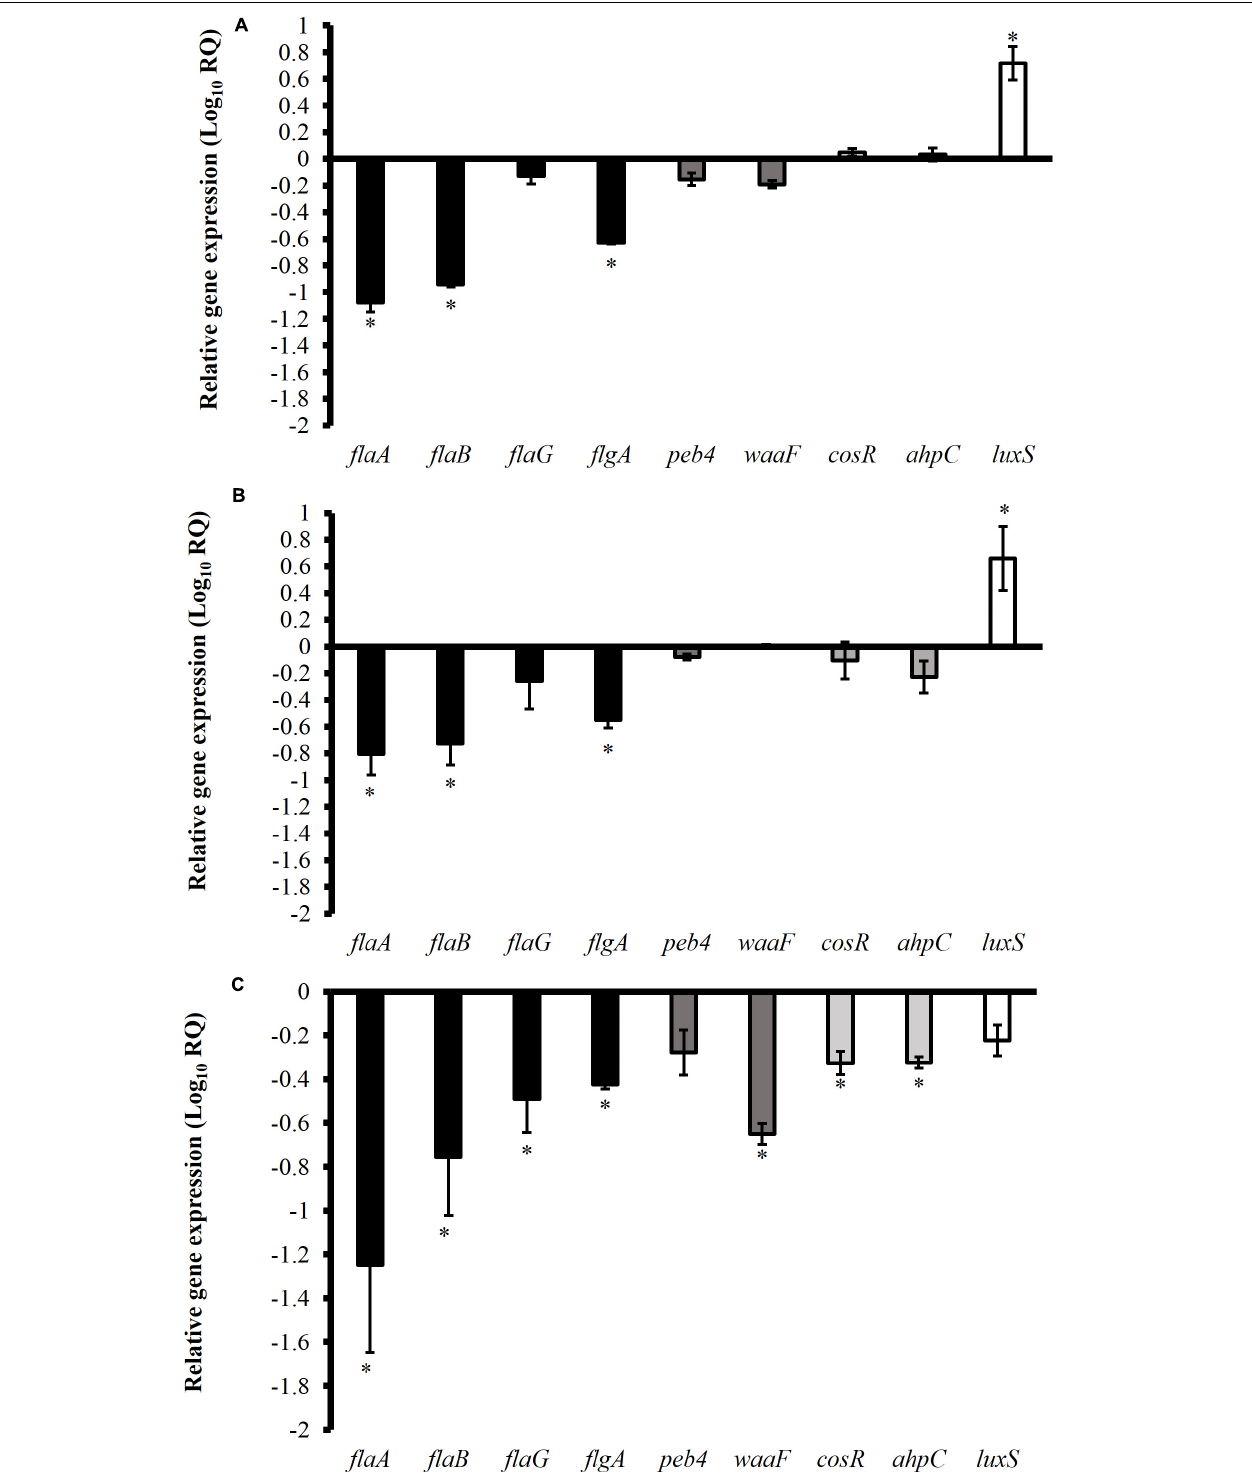
FIGURE 5 | Effect of SICs of trans -cinnamaldehyde (A) , carvacrol (B) , and eugenol (C) on the expression of Campylobacter jejuni (NCTC 11168) genes critical for biofilm formation. Error bars represent SEM ( n = 6). C. jejuni ( ∼ 6.0 Log CFU/mL) in the presence of TC (0.75 mM), EG (0.61 mM) or CR (0.13 mM) was incubated at 37 ◦ C for 12 h followed by RNA extraction and cDNA synthesis. RT-qPCR was conducted with 16S-rRNA serving as endogenous control. ∗ indicates significant change in the expression of genes at P < 0.05.